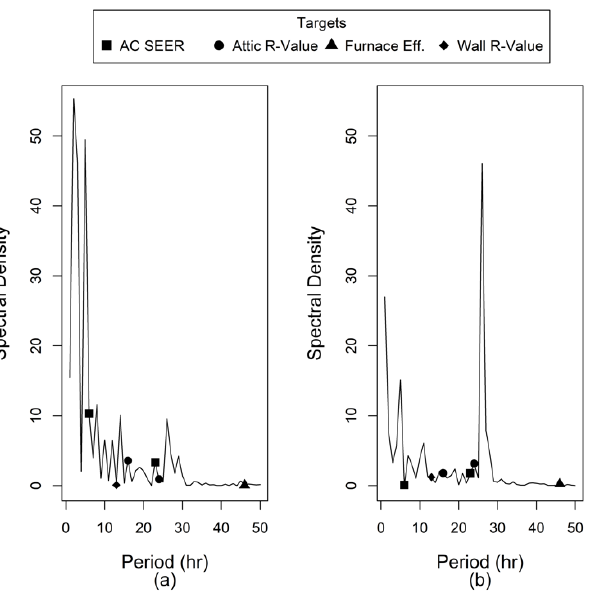
Figure 4. Power spectrum for the indoor temperature measured at the thermostat for ( a ) high- and ( b ) low-efficiency houses for the most important frequencies identified.